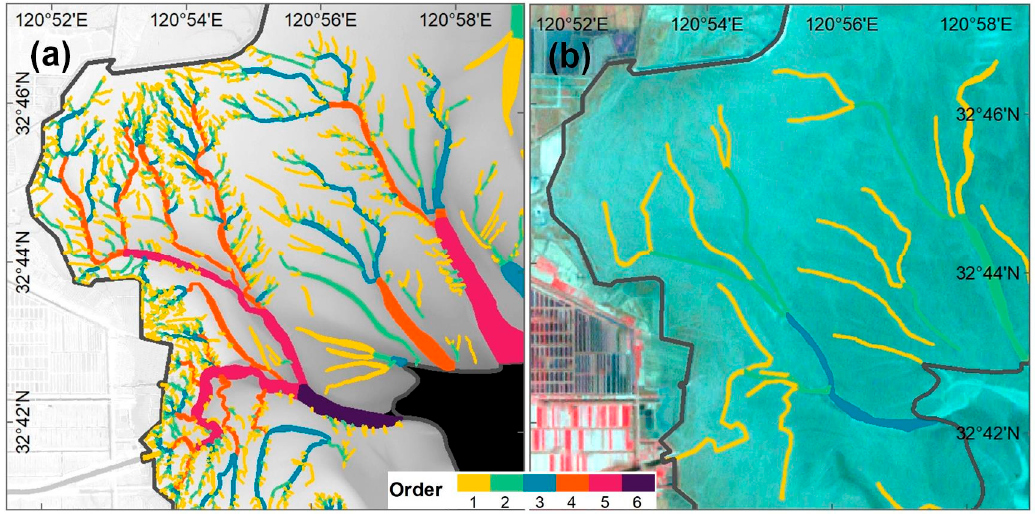
Figure 14. Morphological characteristics of tidal creeks in the Jiang Harbor. Extraction and order definition of tidal creeks using (a) a LiDAR DEM and (b) TM images. The black line indicates the edge of the reclamation area.